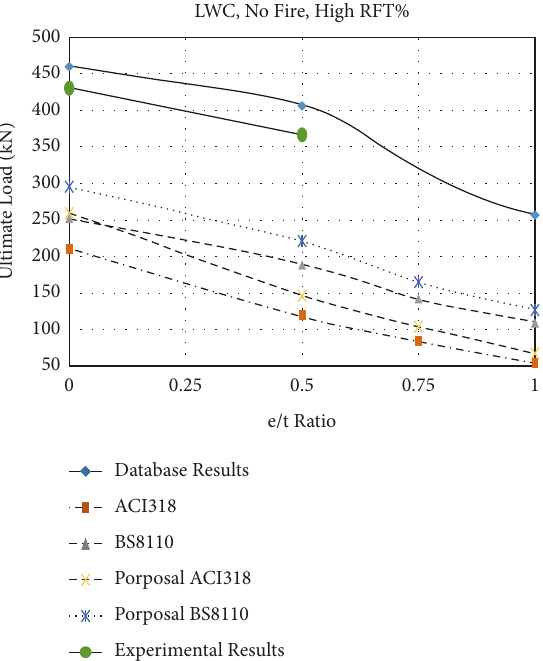
Figure 14: Comparison of LWC database-ultimate loads and different codes using the proposal factors.